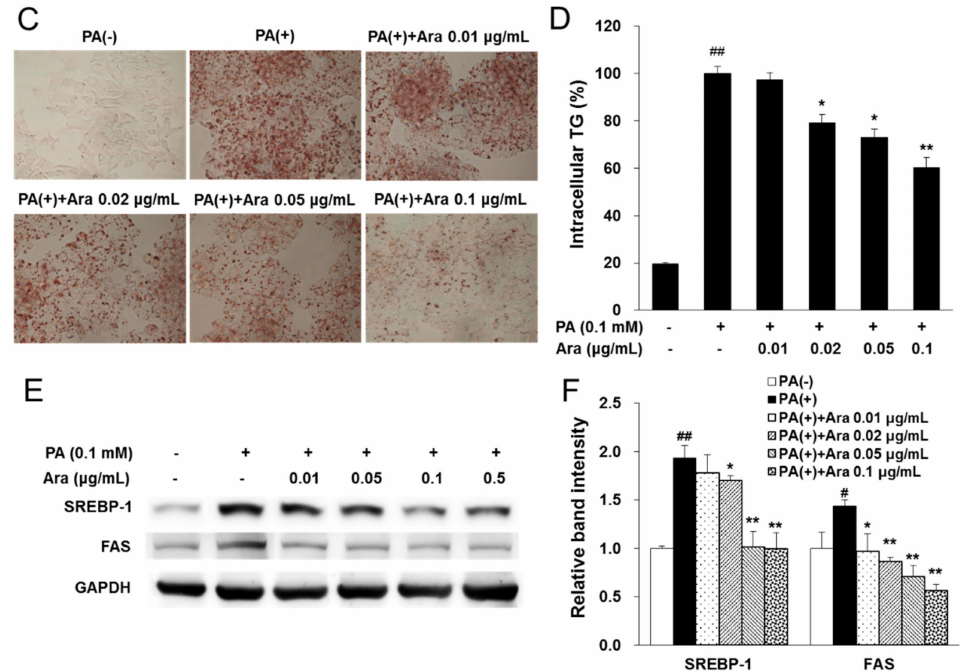
Figure 4. Arazyme reduced intracellular lipid accumulation in PA-induced HepG2 cells. ( A , B ) Viability of arazyme in HepG2 cells treated with arazyme. Cells were incubated with the indicated concentrations of arazyme for 24 h without ( A ) or with ( B ) PA. Oil-red O staining images ( C , × 200 magnification) and intracellular TG contents ( D ). ( E , F ) Protein expression levels of SREBP-1 and FAS were detected by Western blotting. Data are presented as means ± SD ( n = 3). # p < 0.05, ## p < 0.01 vs. cells treated with medium only; * p < 0.05, ** p < 0.01 vs. cells treated with PA only by Student’s t -tests.